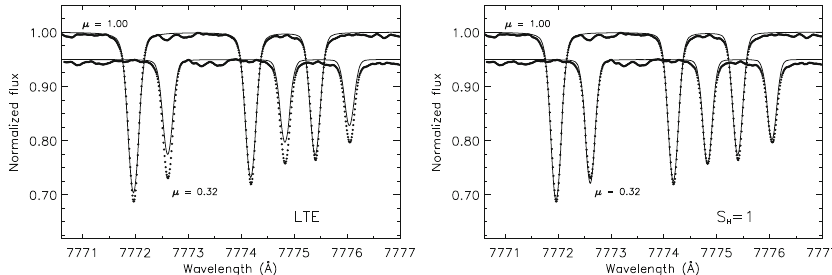
Fig. 5 Observed behavior of the O i triplet at 777nm in the Sun as a function of the inclination of rays from the solar surface ( μ = cos θ , where θ is the angle between the observer and the normal to the solar surface). The filled circles correspond to observations, and the solid lines to models. The observations at disk center ( μ = 1) are reproduced in all cases, by changing the oxygen abundance, and the comparison near the limb ( μ = 0 . 32) tests the realism of the calculations. The behavior of the lines can be reproduced considering inelastic collisions with hydrogen atoms in the rate equations. The factor S H is introduced to enhance the approximate collisional rates from a Drawing-like formula as proposed bySteenbock and Holweger (1984). Image reproduced with permission from Allende Prieto et al. (2004a), copyright by